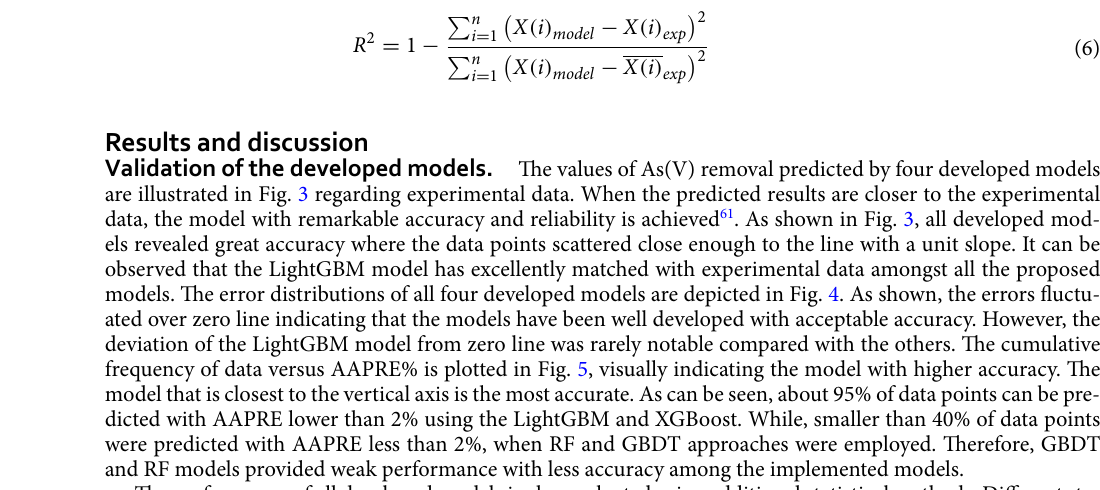
Figure 3. Cross plots of the proposed machine learning models in this study: ( a ) LightGBM, ( b ) XGBoost, ( c ) GBDT, and ( d )